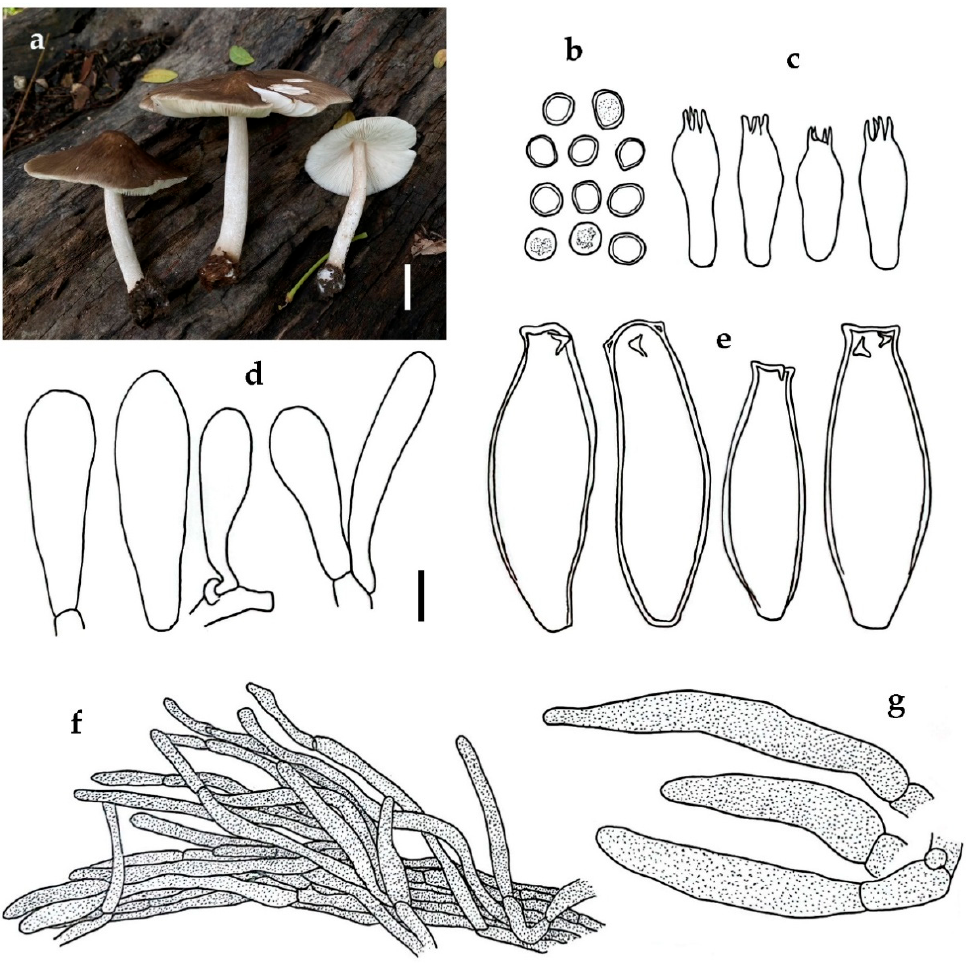
Figure 6. Pluteus losulus SDBR-CMUNK0842: ( a ) habit; ( b ) basidiospores; ( c ) basidia; ( d ) cheilocys- tidia; ( e ) pleurocystidia; ( f ) pileipellis element; ( g ) caulocystidia. Scale bars: ( a ) = 2 mm; ( b – e , g ) = 10 μ m; ( f ) = 25 μ m.